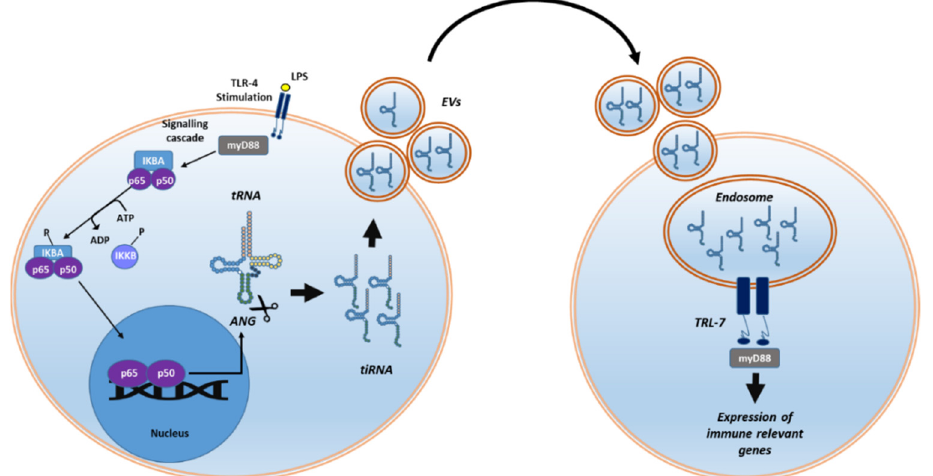
Figure 4. The stimulation of the membrane by TLR activates NF-kB and leads to overexpression of ANG . Angiogenin cleaves the anticodon loops of tRNAs producing 5 ′ -tiRNAs that are secreted as signalling molecules after being packed into EVs. TLR-7 is activated when the complex EV-5 ′ -tiRNAs are transported into endosomes in targeted cells, followed by the activation of immunological responses.